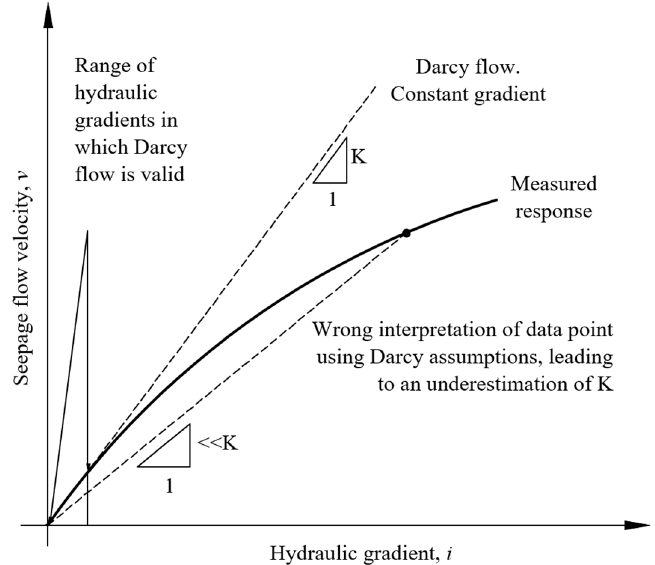
Figure 4. Limits of applicability of Darcy assumptions when testing at variable hydraulic gradients [14].